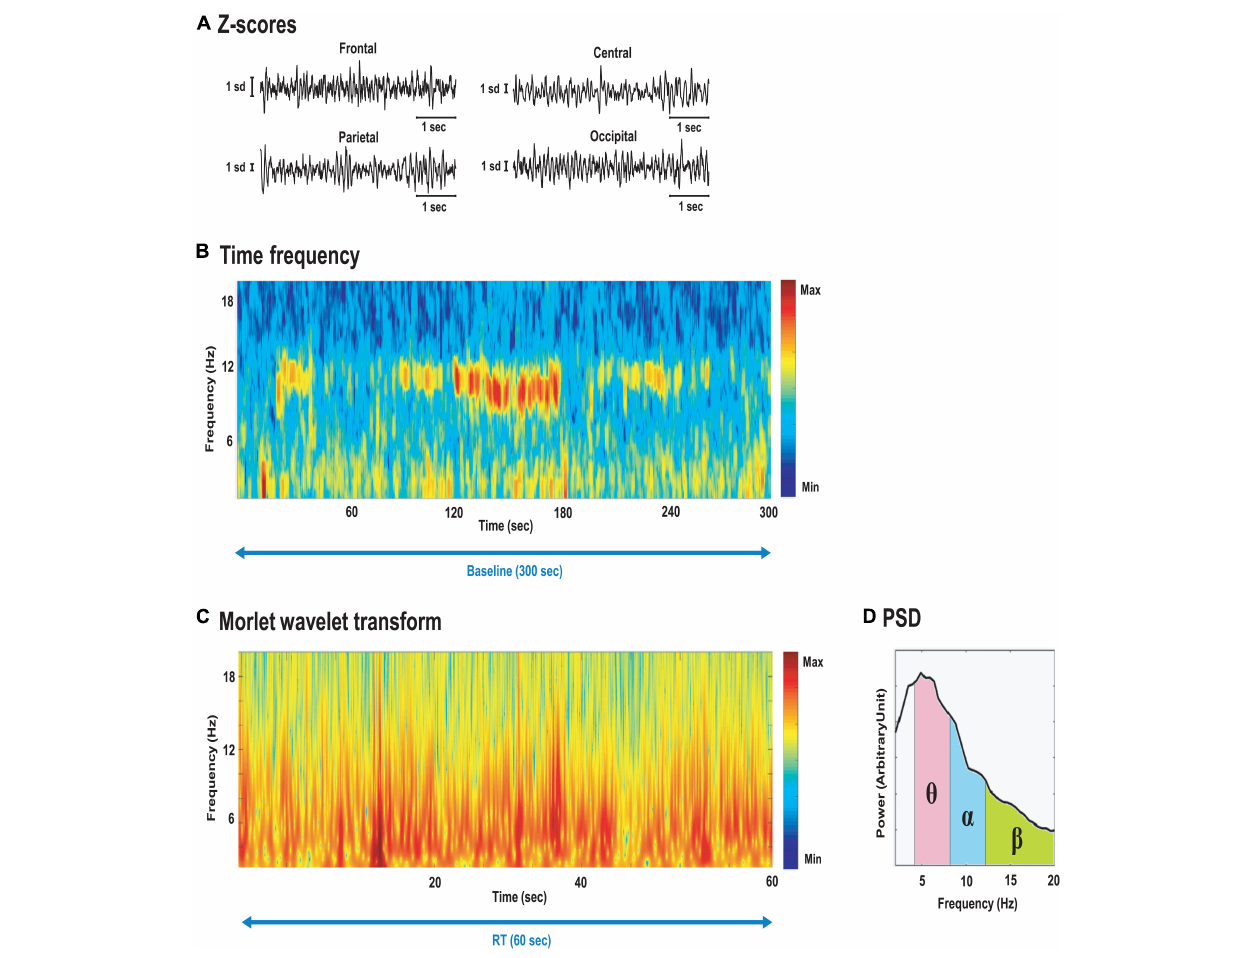
FIGURE 3 | (A) LFP Z-scored trace for frontal, central, parietal and occipital electrodes; (B) Spectrogram of O2 electrode signal during the entire baseline parked (300 s). Note the emergence of alpha burst (8–12 Hz range) during the 1 min with eyes closed (from minute 2 to 3); (C) Time-resolved power spectral density